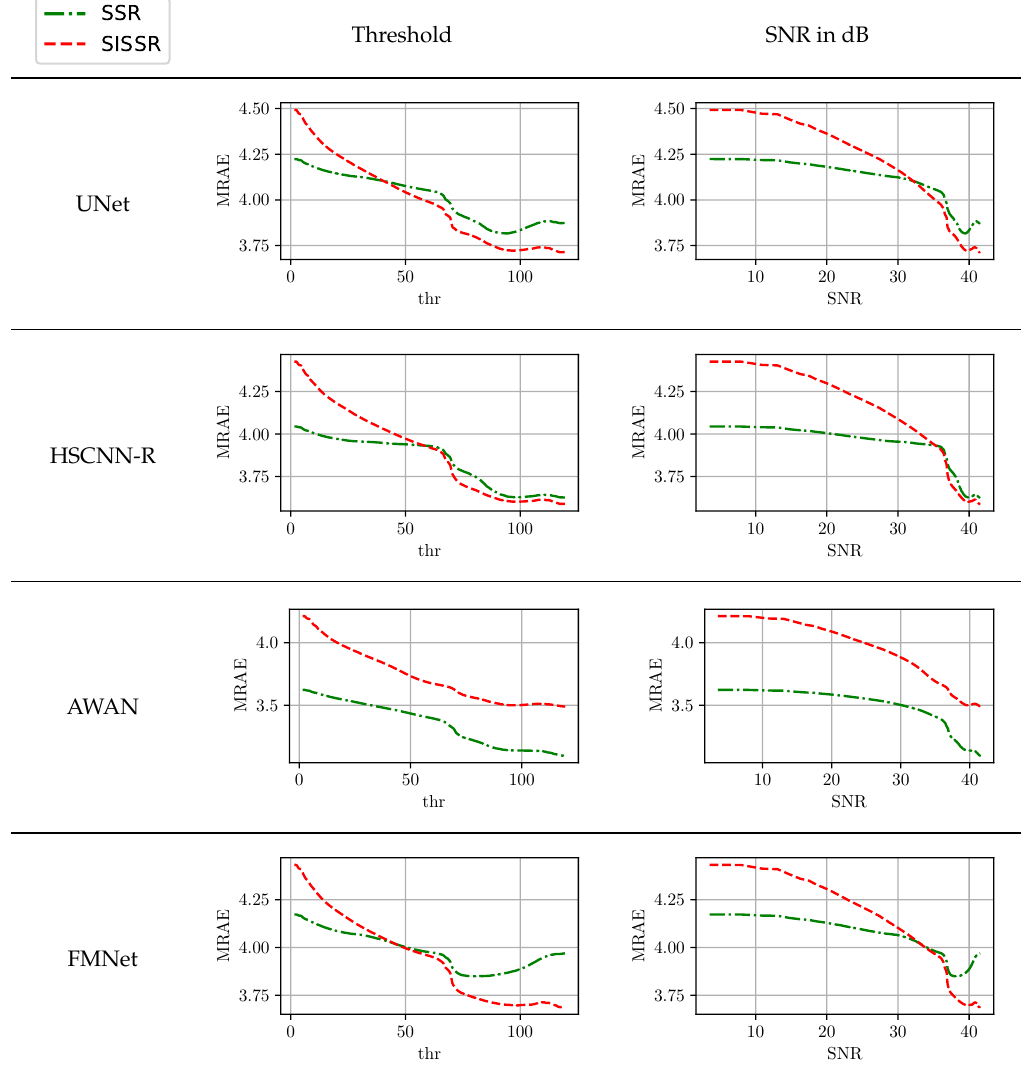
Figure 6. The influence of RGB signal noise on the spectral reconstruction